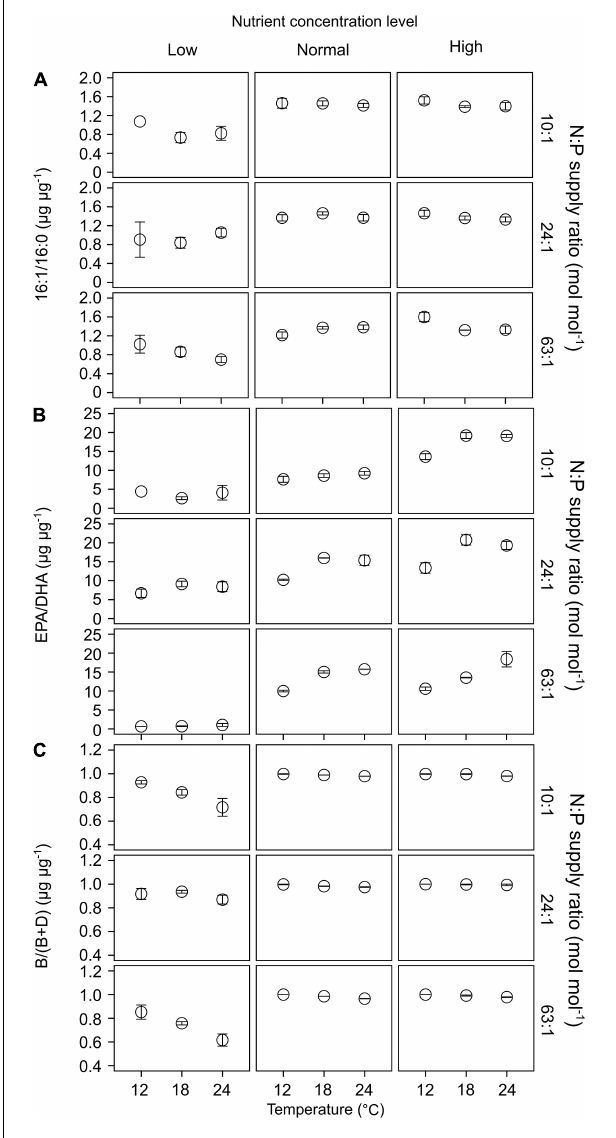
FIGURE 6 | The responses of lipid biomarker ratios (mean ± SE) to temperature, N:P supply ratios and nutrient concentrations in the bicultures of Phaeodactylum tricornutum and Prorocentrum minimum : (A) 16:1/16:0, (B) EPA/DHA, and (C) the ratios of brassicasterol/epi-brassicasterol to (brassicasterol/epi-brassicasterol + dinosterol) [B/(B +